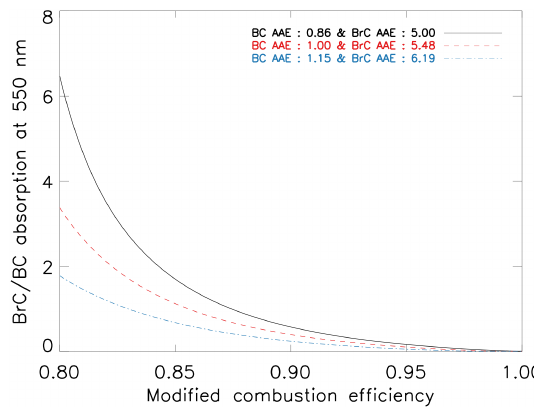
Figure 1. Estimated absorption ratios of BrC to BC at 550nm as a function of MCE. We assume that the CA absorption is only contributed by BC and BrC absorption. Black solid line indicates case 1, red dashed line represents case 2, and blue dotted line shows case